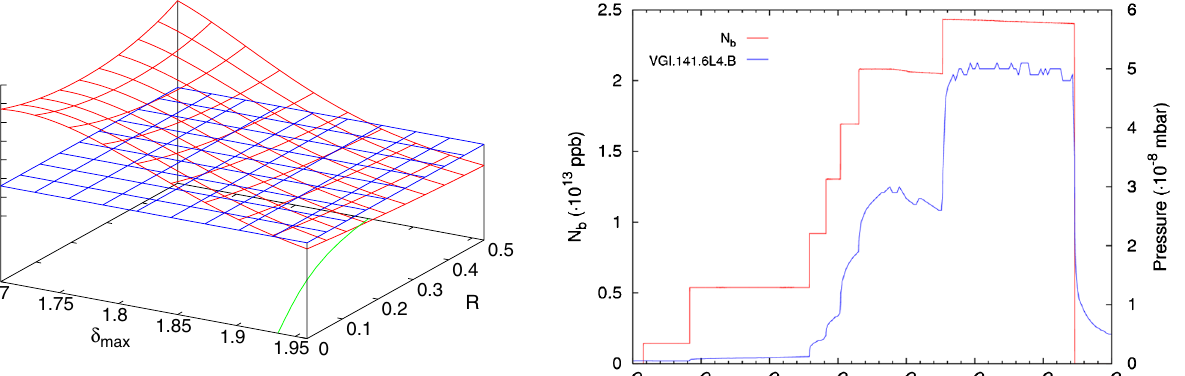
FIG. 2. Example of a 3D surface of simulated fluxes for the case (cid:2) b =(cid:2) a (red) cut by a plane surface (blue) at the value equal to the ratio of the corresponding measured pressures ( P b =P a ¼ 161 : 0 ). The bottom plane shows the contour of the intersection between both surfaces (green).